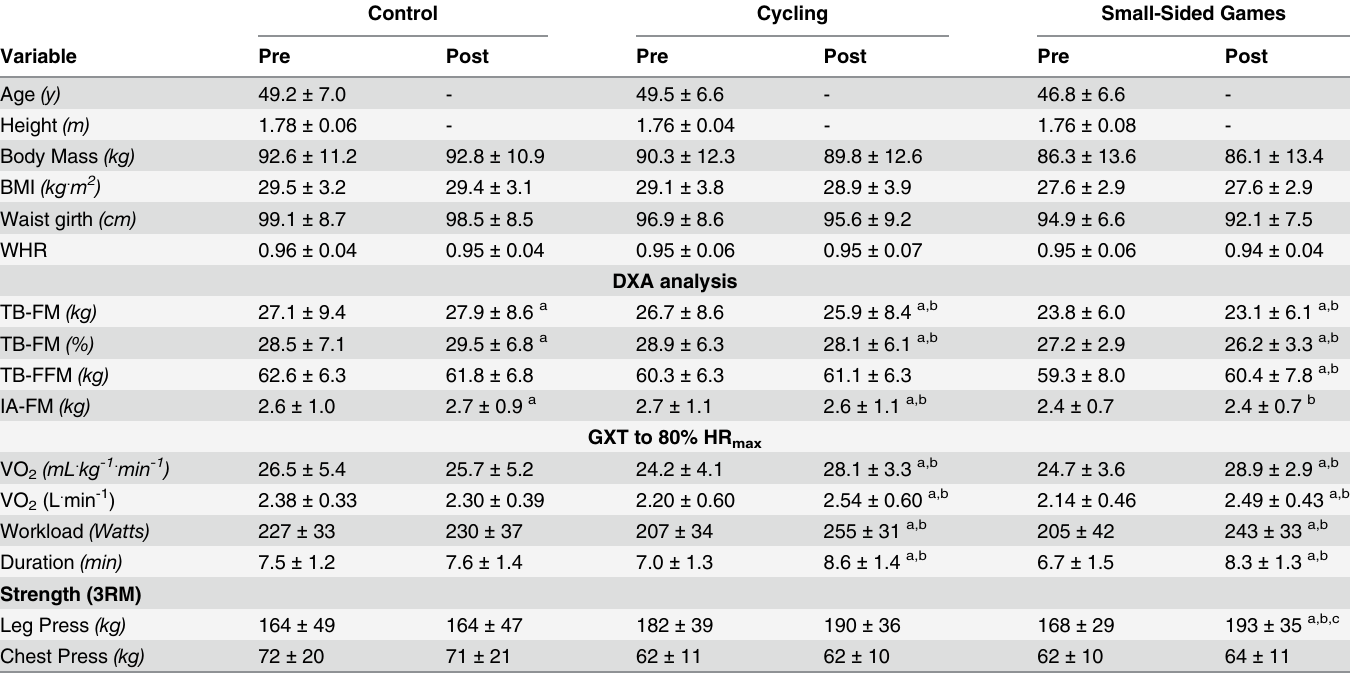
Table 1. Mean ± SD participant characteristics, anthropometry, body composition, aerobic capacity and strength pre and post 8 weeks of control (n = 11), continuous cycling (n = 11) or small-sided games (n =